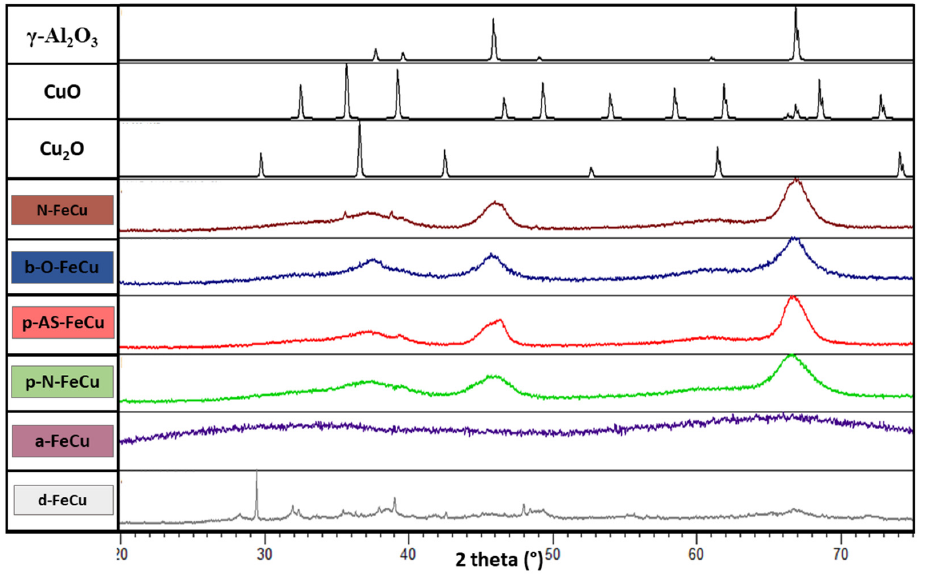
Figure 3. XRD patterns of calcined iron-alumina precursors impregnated with copper and reference patterns of γ -Al 2 O 3 (PDF 00-050-0741), CuO (PDF 00-045-0937) and Cu 2 O (PDF 00-002-1067).